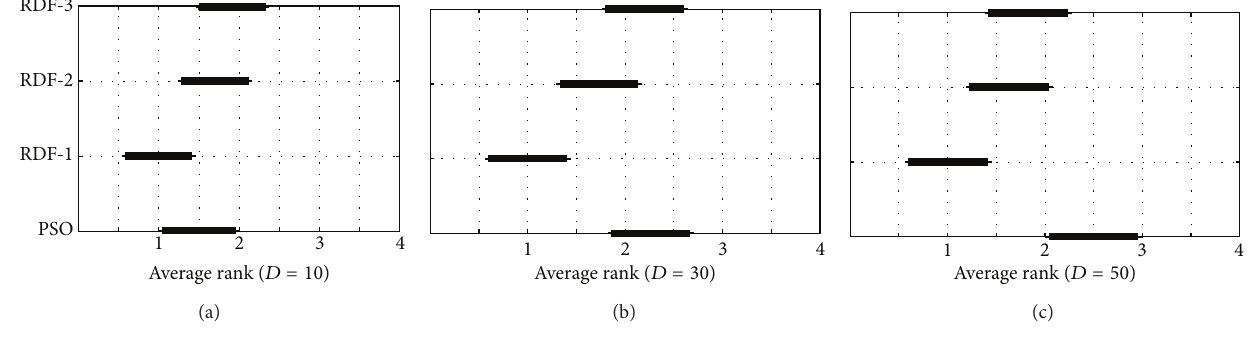
Figure 4: Results of the Friedman nonparametric